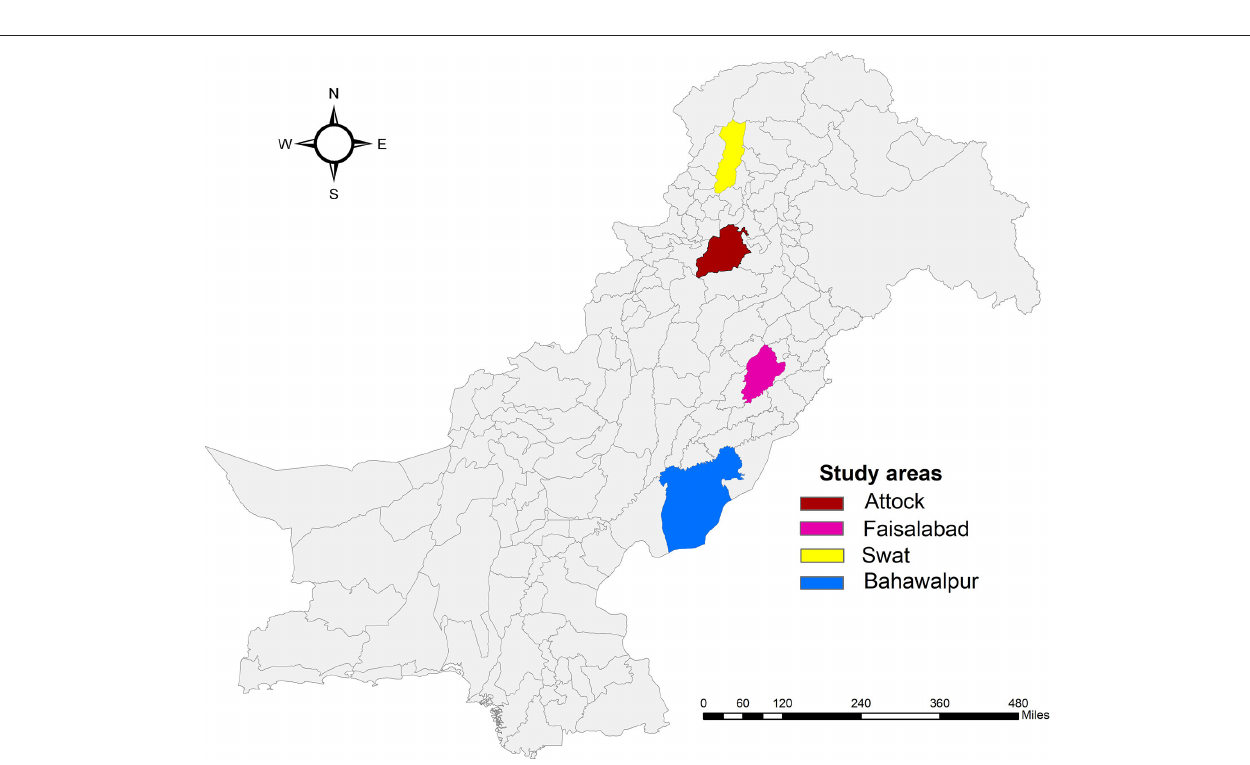
FIGURE 2 | A map of Pakistan showing the locations of the four regions in which the study was conducted.